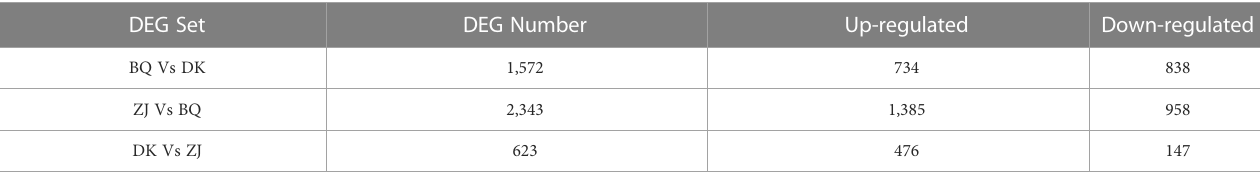
TABLE 2 Differentially expressed genes between pairs of samples.